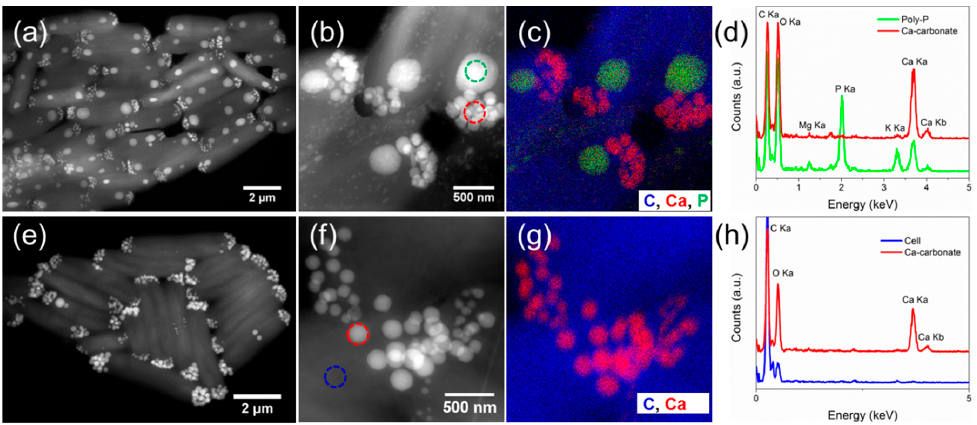
Figure 2. ( a , b ) HAADF-STEM images of Ca . S. calcipolaris G9 cells grown in BG-11. ( c ) STEM-EDXS map of G9 cells (same area as in ( b )); ( d ) EDX spectra extracted from Ca-carbonate (red line) and polyphosphate (green line) inclusions which are indicated by red and green dashed circles in image b, respectively; ( e , f ) HAADF-STEM images of G9 cells grown in MS-2; ( g ) STEM-EDXS map of G9 cells (same area in ( f )); ( h ) EDX spectra extracted from Ca-carbonate (red line) and cytoplasm as a background (cell, blue line) which are indicated by red and blue dashed circles on image ( f ), respectively. In ( c , g ), each color in the elemental map corresponds to one element indicated by its own symbol with the same color.